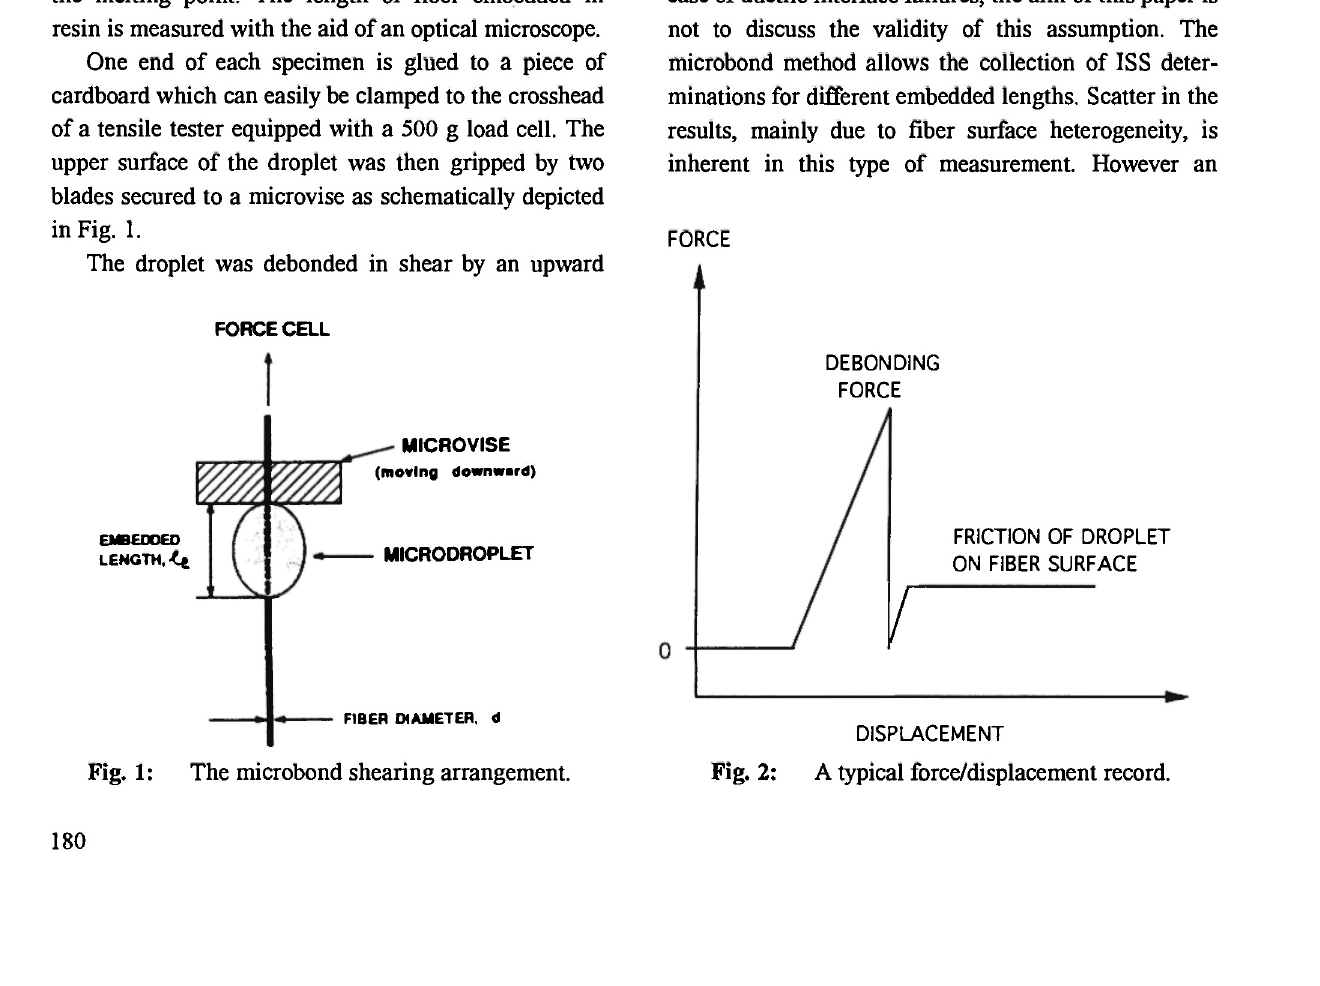
Fig. 1: The microbond shearing arrangement. Fig. 2: A typical force/displacement